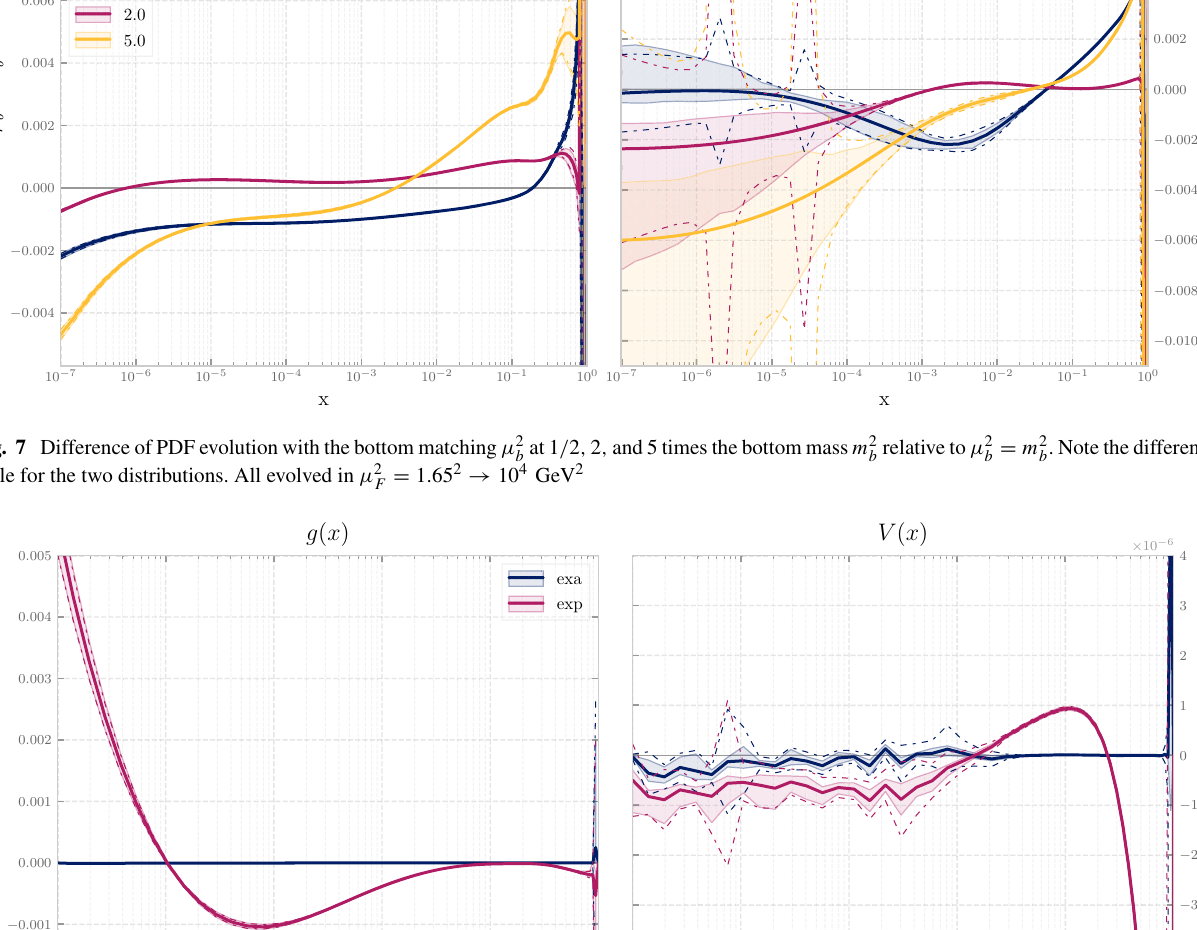
Fig. 8 Relative distance of the product of two opposite NNLO EKOs and the identity matrix, in case of exact inverse and expanded match- ing (see Eq. (12)) when crossing the bottom threshold scale μ 2